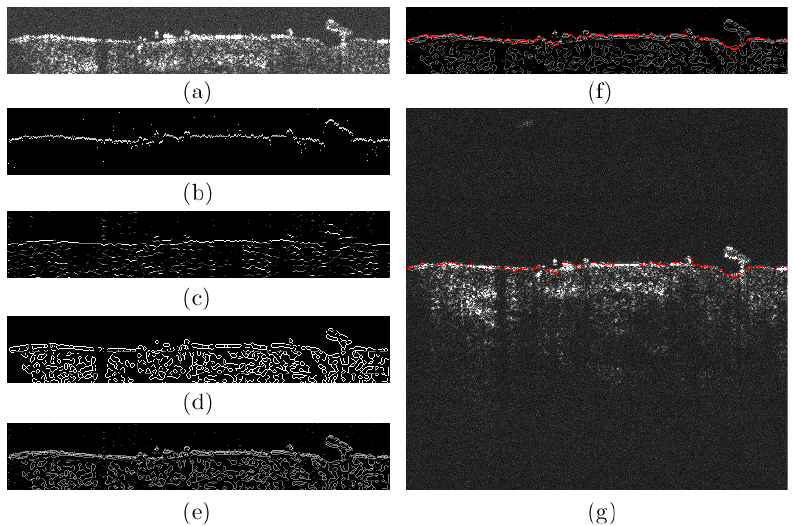
Fig. 2. Energy map step. (a) ROI of raw image. (b) intensity detector. (c) Sobel detector. (d) Canny detector (e) weighted energy map. (f) red line: shortest-path pro¯le. (g) red line: extracted surface.